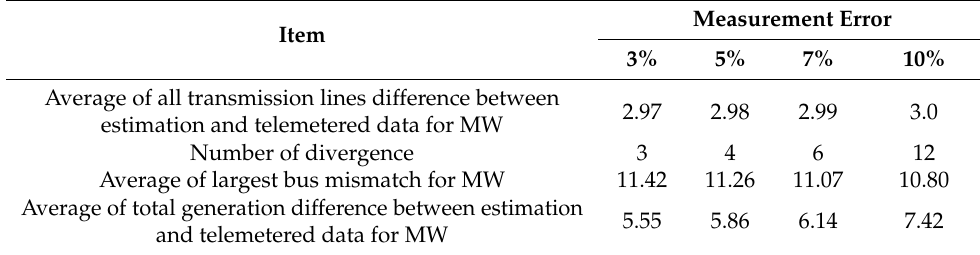
Table 19. Performance of the state estimation for the metering